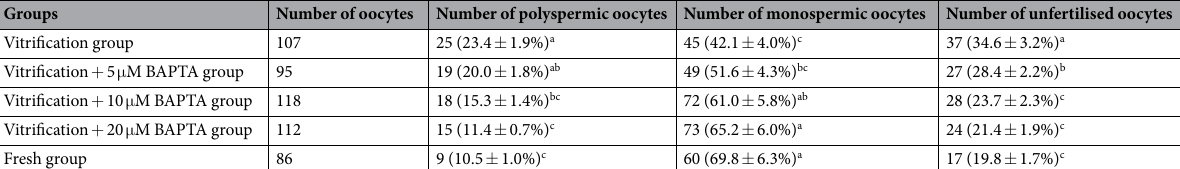
Table 2. Effect of BAPTA treatment on the fertilisation capacity of vitrified bovine oocytes. a,b,c Values with different superscripts differ significantly within the same column ( P <